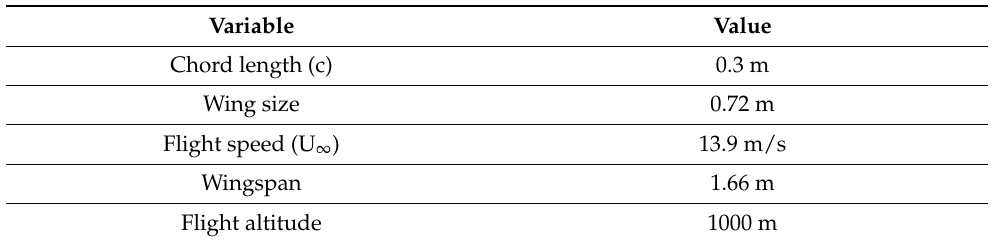
Table 1. Main CFD parameters and dimensional characteristics of a Canada goose [25,27]. Numeri- cal conditions are determined assuming that the bird flies at an altitude of 1000 m [26].